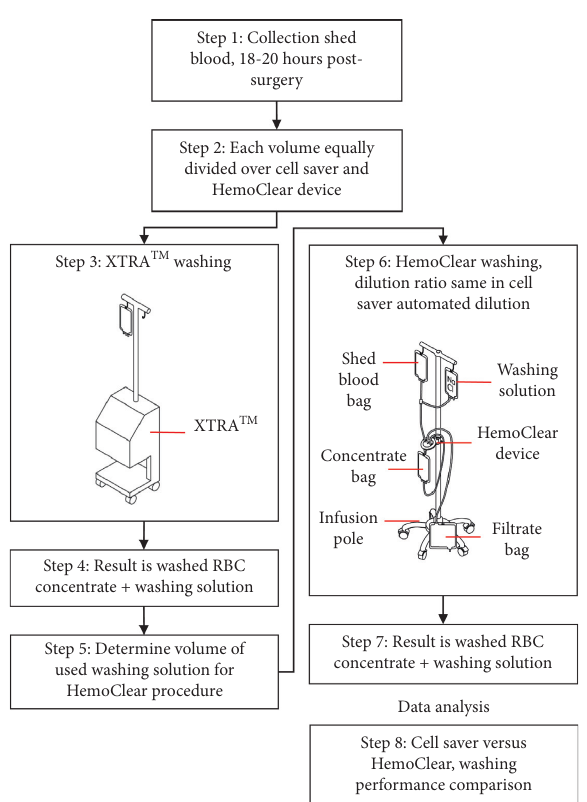
Figure 3: Schematic illustration of the study design. Each shed blood sample is aliquoted in two volumes, to be washed by the cell saver machine and HemoClear device. Washing with the cell saver device is performed firstly, and the automatically used washing volume determined. Subsequently, the same volume is used in the HemoClear device set-up; the HemoClear device is attached to an infusion pole. Preprocessed blood bags and processed bags are hung above and below the device, respectively.